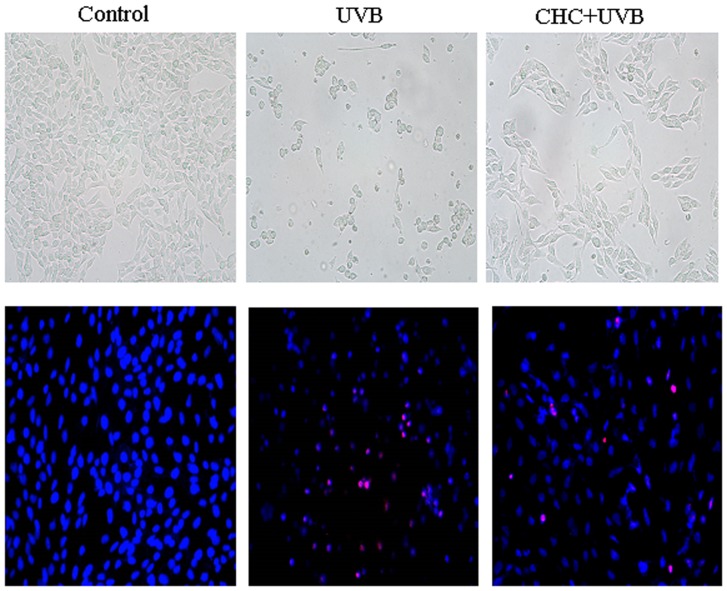
Representative light micrographs (A–C) and fluorescence micrographs of Hoechst33342 (blue)/PI (red) double staining (D–F) of normal RGC-5 cells, cells subjected to UVB irradiation and cells treated with 10 µM CHC and UVB irradiation.Normal control cells grew as an interconnected monolayer and exhibited axonal processes (A). Cells after UVB exposure became cuboidal and crenate in shape with the presence of vacuoles (B), which was markedly ameliorated with CHC pretreatment (C). Control cells showed normal nuclear morphology and are negatively stained for PI (D). UVB-irradiated cells including PI-positive cells, showed shrinkage and condensation of their nuclei (E). Treatment with 10 µM CHC reduced both nuclear shrinkage and PI-positive staining (F). Magnification is×200.